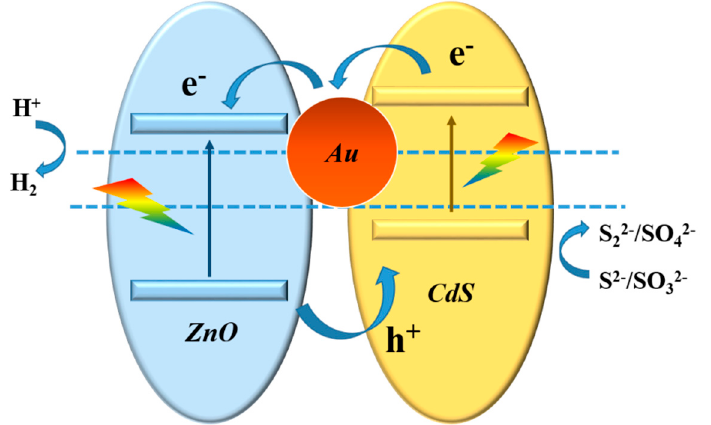
Figure 9. Schematic illustration of charge transfer process and gas evolution mechanism of ZnO/Au/CdS sample.